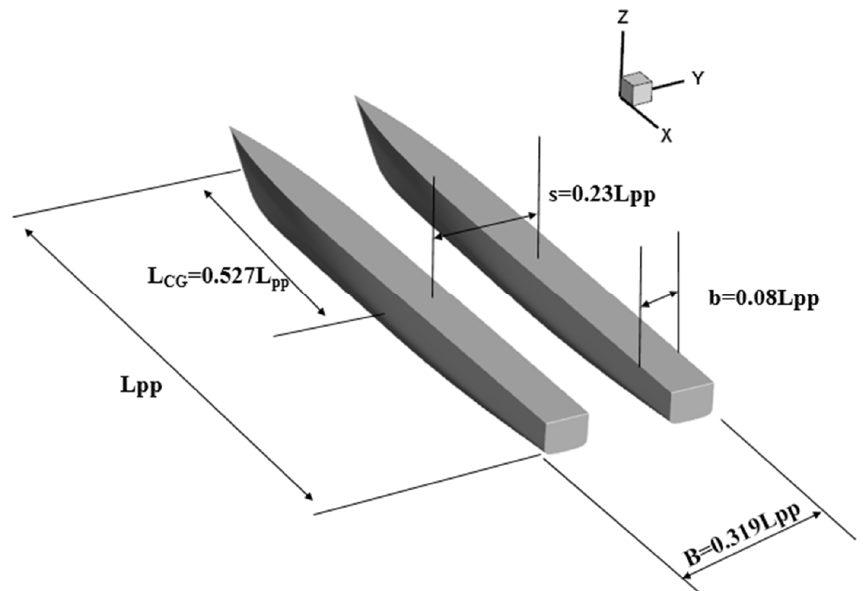
Figure 2. The geometry of the Delft catamaran.